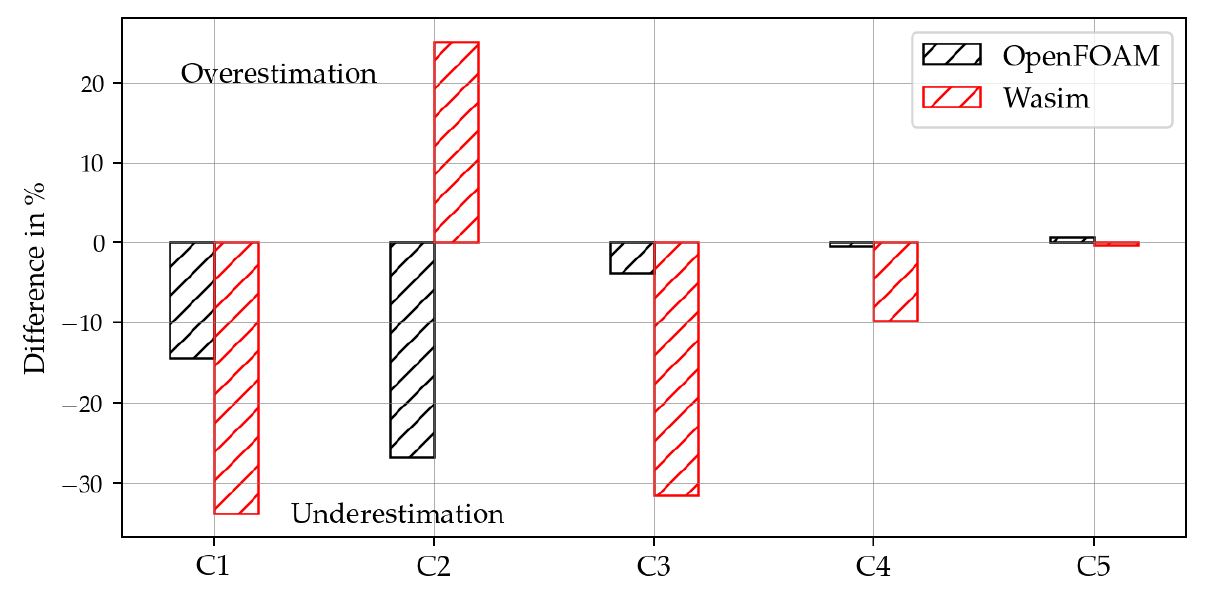
Figure 30. Difference of numerical and experimental heave transfer functions for the KRISO containership. Table 10. Difference of numerical and experimental pitch transfer functions for the KRISO contain- ership.